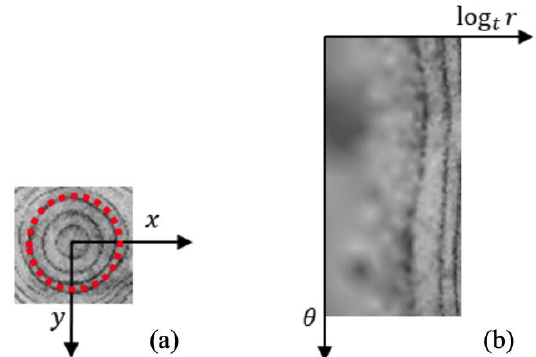
Figure 3. An example of Log-polar coordinate transformation. ( a ) a circular feature region of a 24-pixel radius in the Cartesian coordinate system (the area in the dotted circle). ( b ) transformed rectangular block (74 × 150 pixels) in the Log-polar coordinate system.